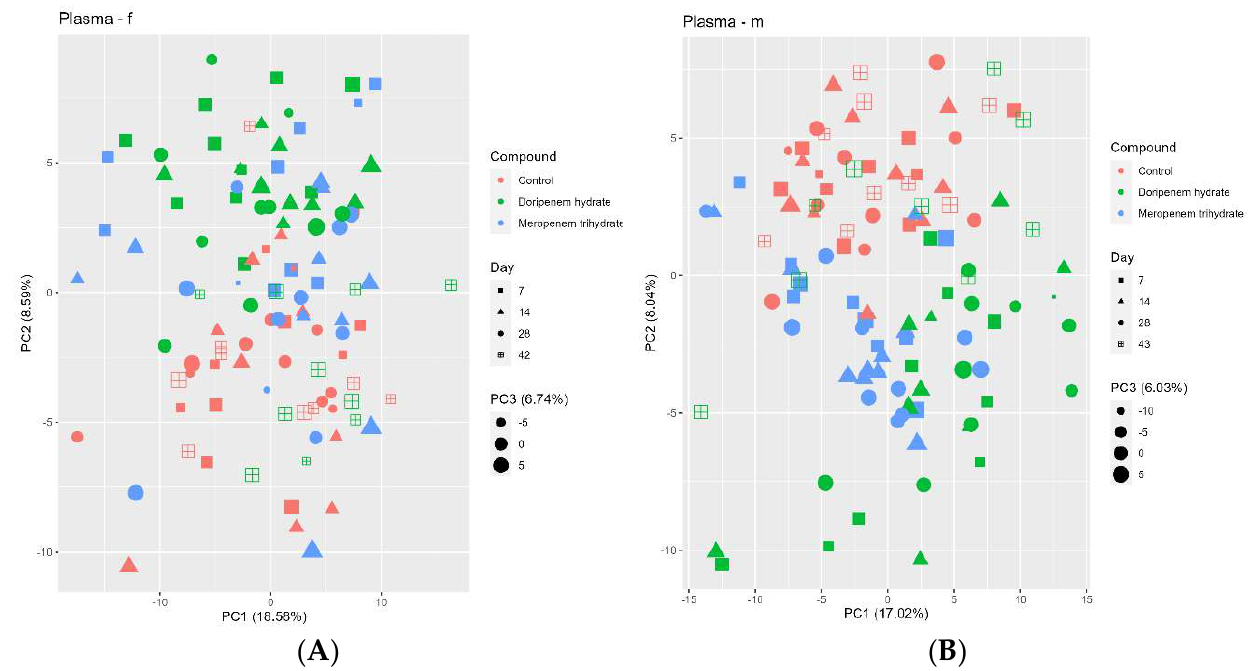
Figure 9. Principal component analysis (PCA) of the blood plasma metabolome profiles of controls (red), meropenem- (blue), and doripenem- (green) treated rats. PCA for plasma metabolome profiles of ( A ) female and ( B ) male Wistar rats on days 7, 14, and 28 of the study and on day 42/43 for the doripenem-recovery group. The data points are sized by the PC3 value. Different shapes of the data points represent respective sampling time points. Dose group-specific effects were marginal, so the groups were not separated based on the dose levels.